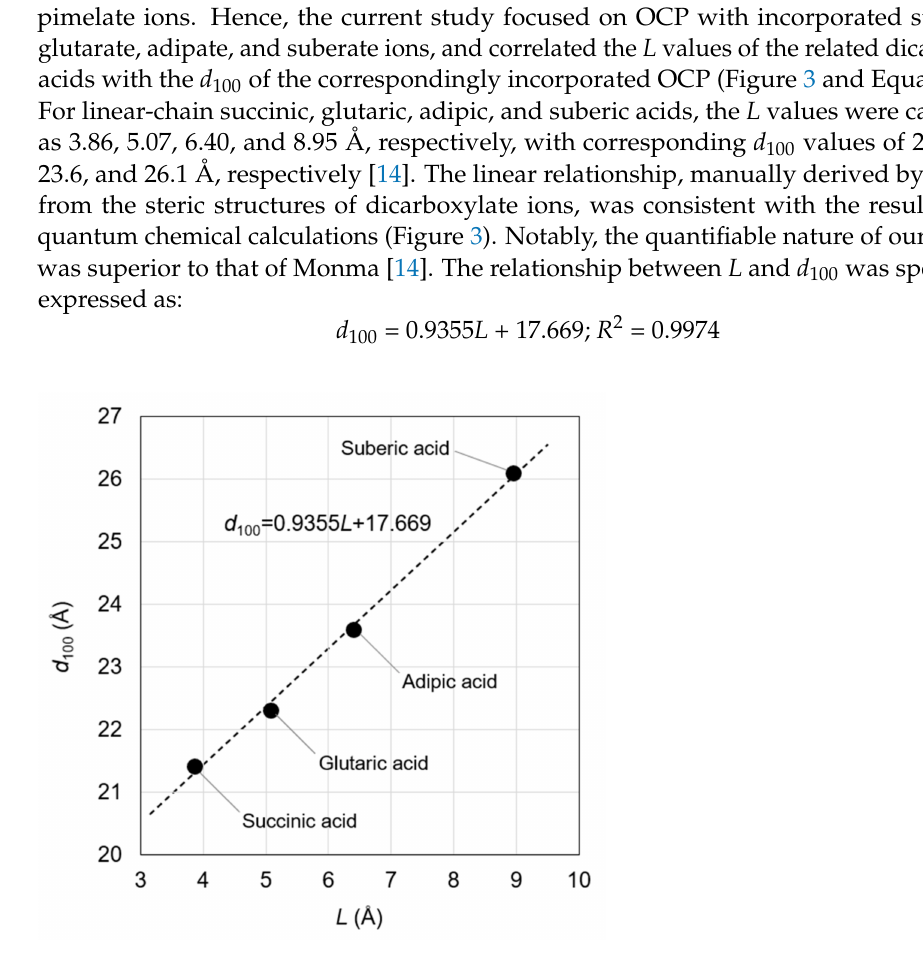
Figure 3. Relationship between L and d 100 in OCP with incorporated carboxylate ions. Notably, the correlation coefficient ( R 2 ) of this approximate straight line is